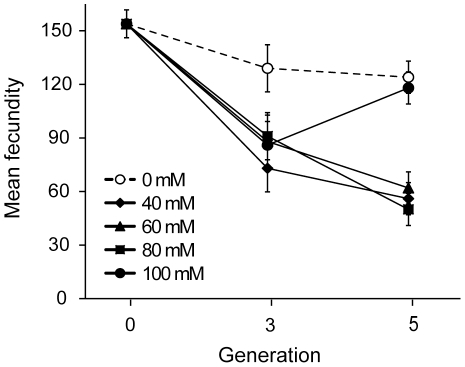
Time series EMS dose response curve.Replicate populations of PX385 were exposed to five generations of mutagenesis across a range of different EMS concentrations. Mean fecundity was assessed prior to mutagenesis, after three generations of mutation, and after five generations of mutation. The mutated populations (solid lines) exhibited reduced mean fecundity, relative to the control populations (dashed line), after three generations (F1,216 = 35.64, P<0.001). Then, after five generations, the populations exposed to 100 mM exhibit a substantial increase in mean fecundity while all of the other mutated populations exhibit further reductions in mean fecundity (P<0.001, Tukey's HSD). Error bars represent two standard errors of the mean.